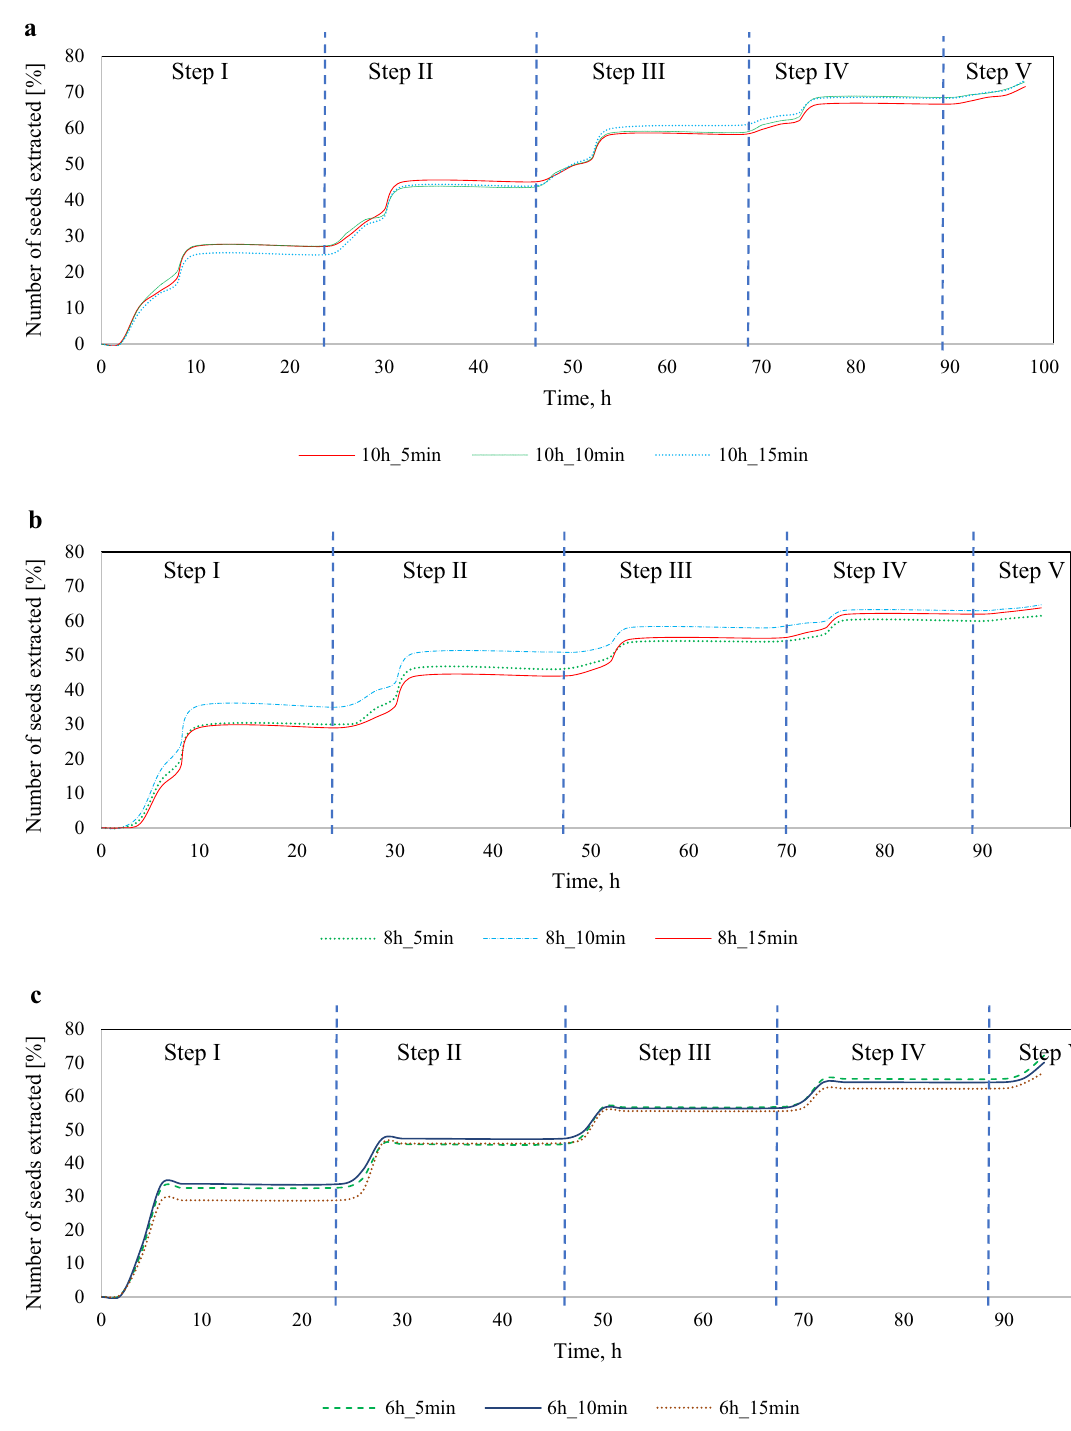
Figure 4. Percentage seed yield dynamics for each step of a five-step extraction process: ( a ) 10 h of drying, (b) 8 h of drying, ( c ) 6 h of